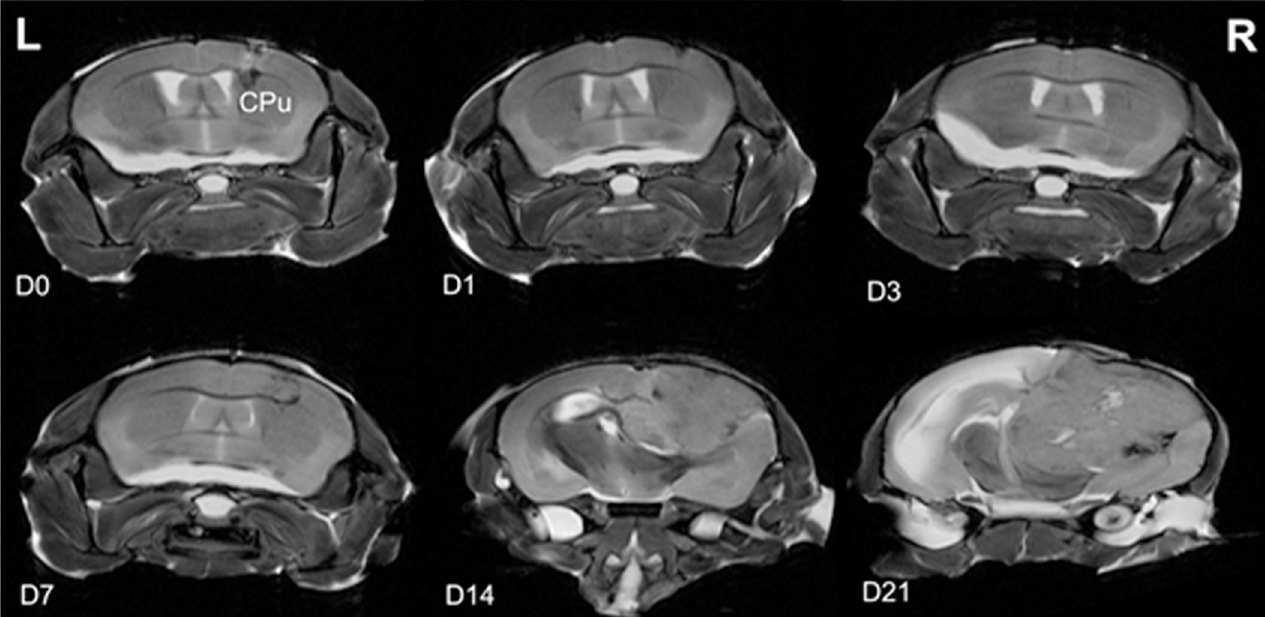
Fig 1. Ex vivo non-contrast T2-weighted 2D MRI scans of ex vivo brains depicting the tumor progression. Panels show MRI scans at day 0 (D0), D1, D3, D7, D14, and D21 post-inoculation of murine glioma Gl261 cells into the caudoputamen (CPu). Left (L) and right (R) of the brain are indicated. Images are representative of N = 3 mice per time